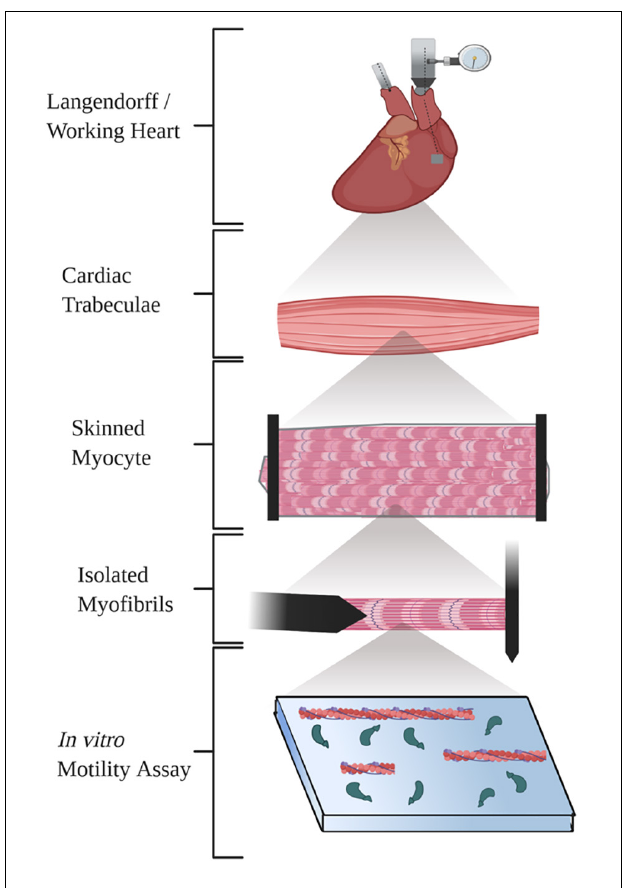
FIGURE 1 | Diagram illustrating the five techniques summarized in the review. Created with